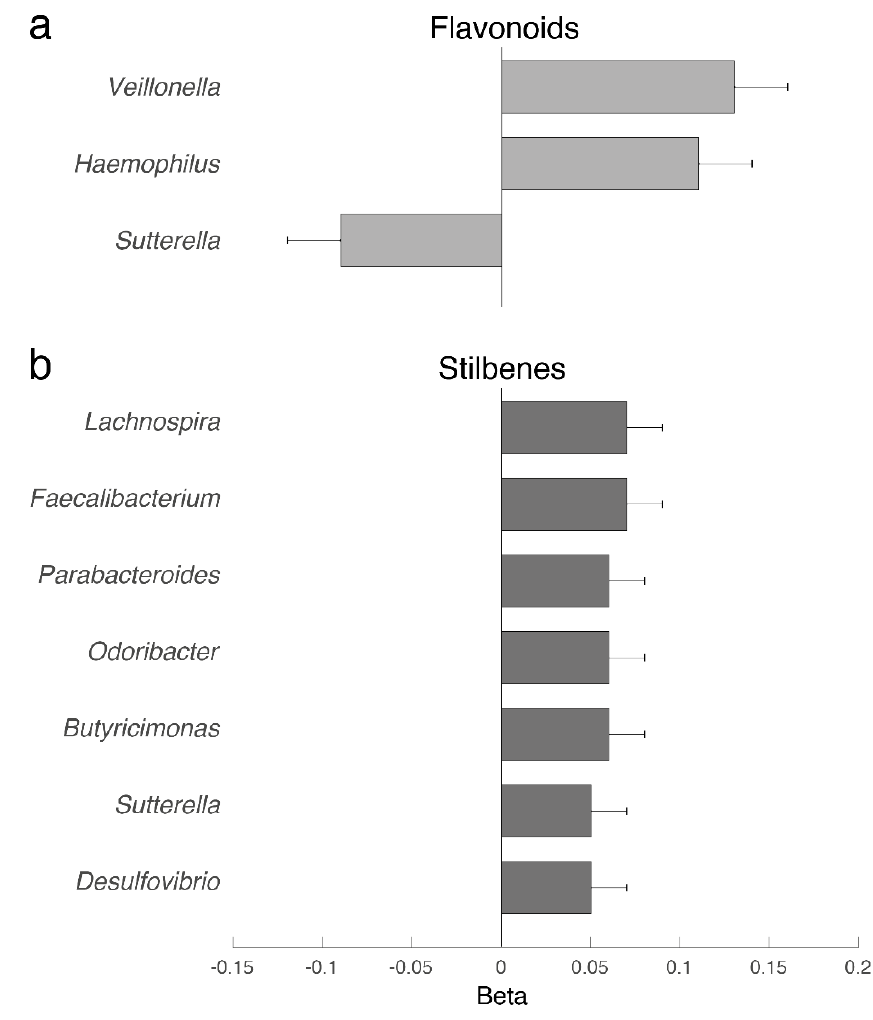
Figure 2. ( a ) Genus–flavonoid intake association. ( b ) Genus–stilbene intake association. Analyses are adjusted for age, BMI, fiber intake, energy intake and multiple testing (FDR < 0.05).